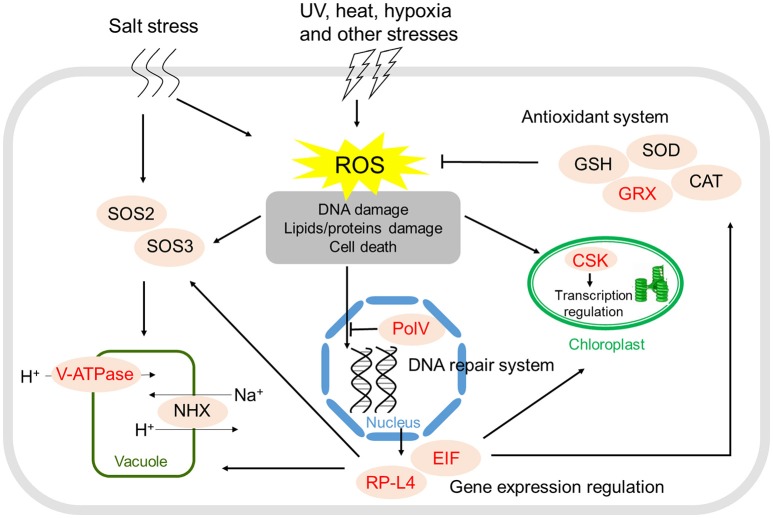
Positively selected genes and stress resistance in the four Rhizophoraceae mangroves. Positively selected genes are marked in red.